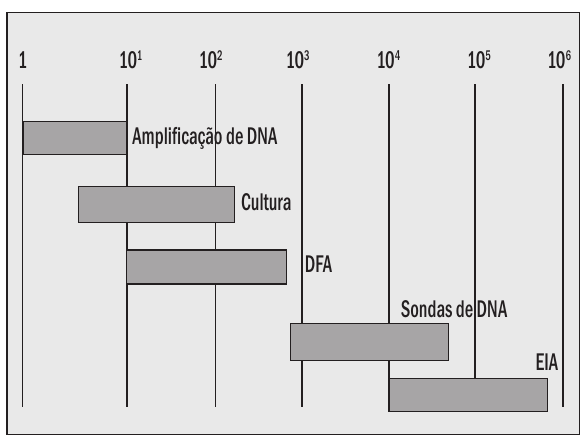
Figura 2 – Comparação dos limites de detecção do número de EB em escala logarítmica entre as diferentes tecnologias usadas no diagnóstico de C. trachomatis (adaptado de Black, Black, M.C. Current methods of laboratory diagnosis of Chlamydia trachomatis infections. Clin. Microbiol. Rev., 10 (1): 160-84,